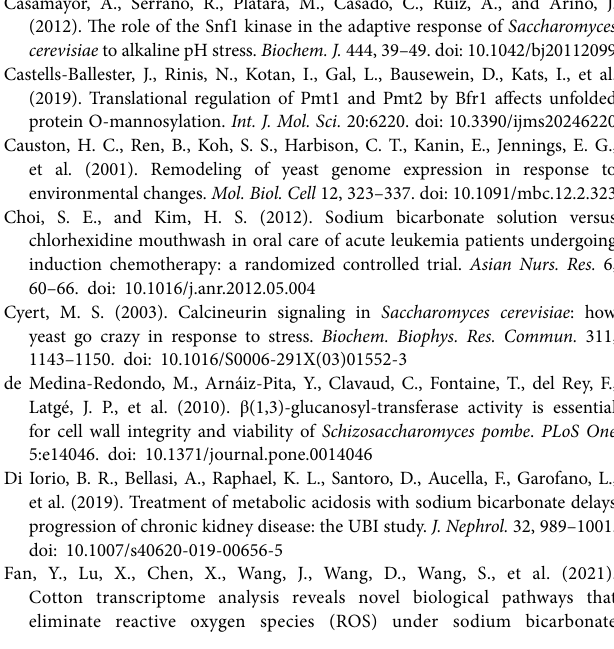
Supplementary Table S1 | Data of the three independent genome- wide